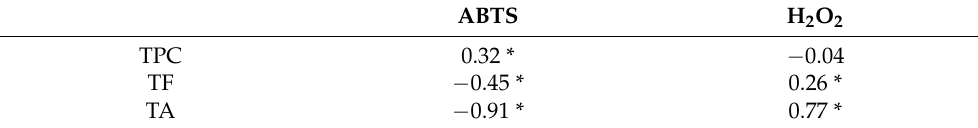
Table 6. Pearson’s correlation coefficients of ABTS and H 2 O 2 scavenging versus TPC, TF, and TA.